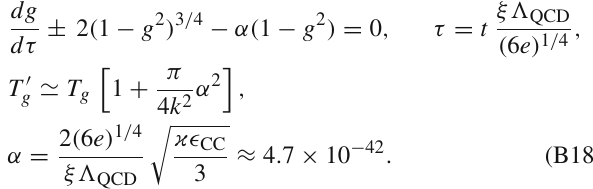
similartoEq.(B14)butwithasmalladditionalterm ∝ α (cid:17) 1